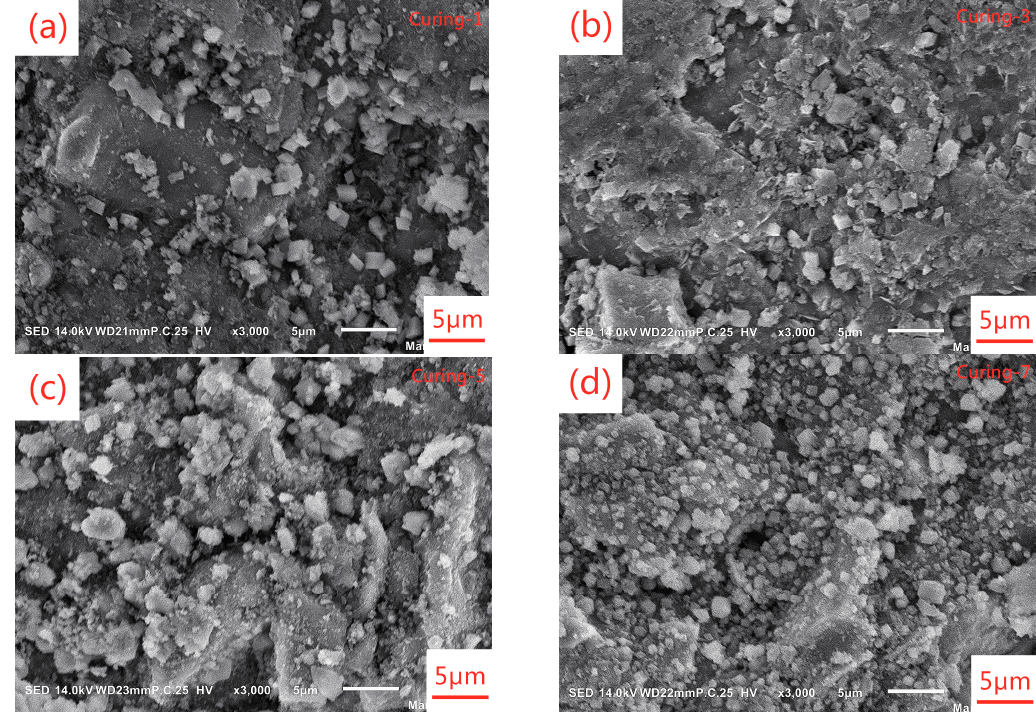
Figure 7. SEM images of AAS pastes: (a) 20 °C water; (b) 60 °C water; (c) air, 20 °C / 60%RH; (d) CO 2 , 20 °C / 60%RH.